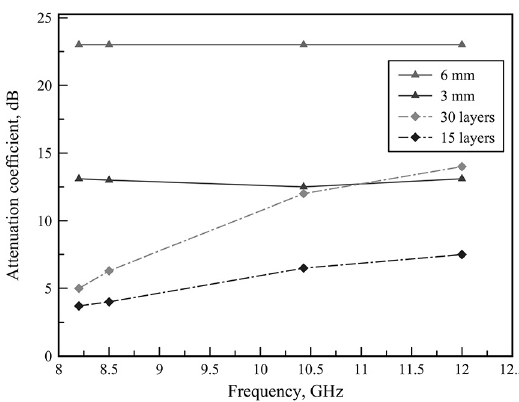
O arrays particles-paraffin 3 4